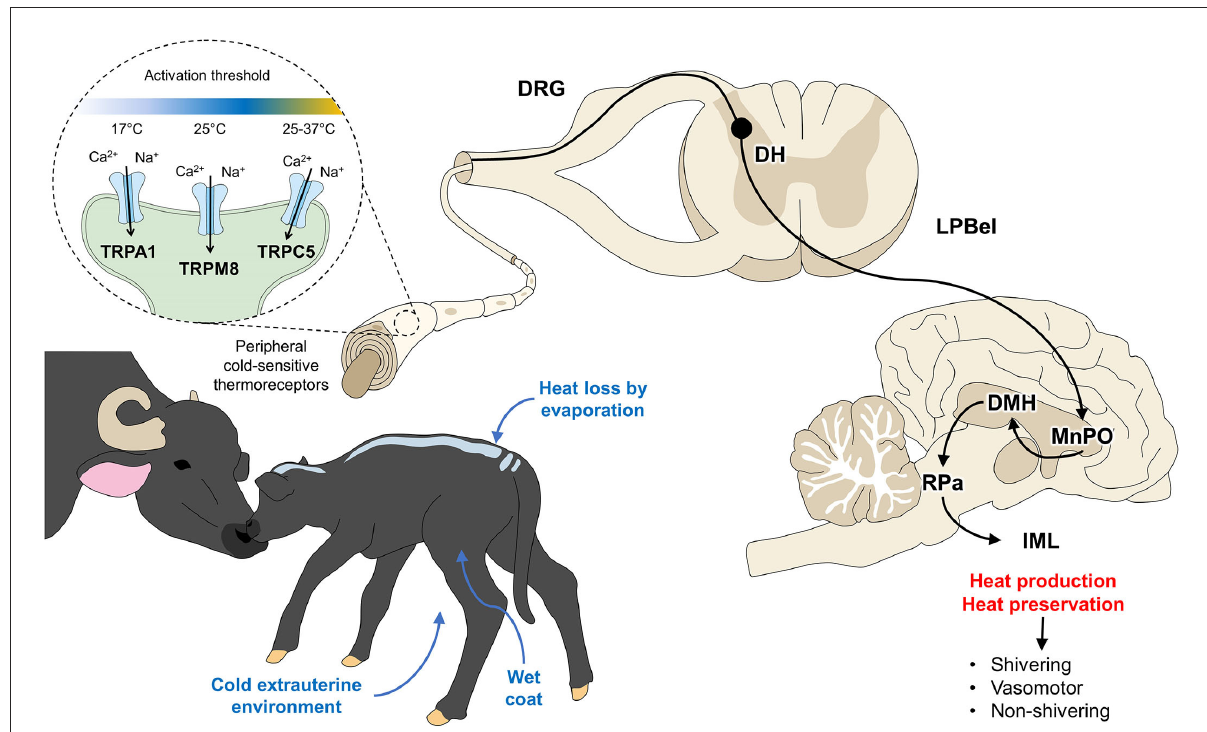
FIGURE3 Hypothalamic response to hypothermia. Ca 2 + , calcium; DH, dorsal horn; DRG, dorsal root ganglion; IML, intermediolateral column; LPBel, external lateral part of the lateral parabrachial nucleus; MnPO, median preoptic nucleus; Na + , sodium; RPa, raphe pallidus. TRPA, transient receptor potential ankyrin 1; TRPC5, transient receptor potential canonical 5; TRPM8, transient receptor potential melastatin